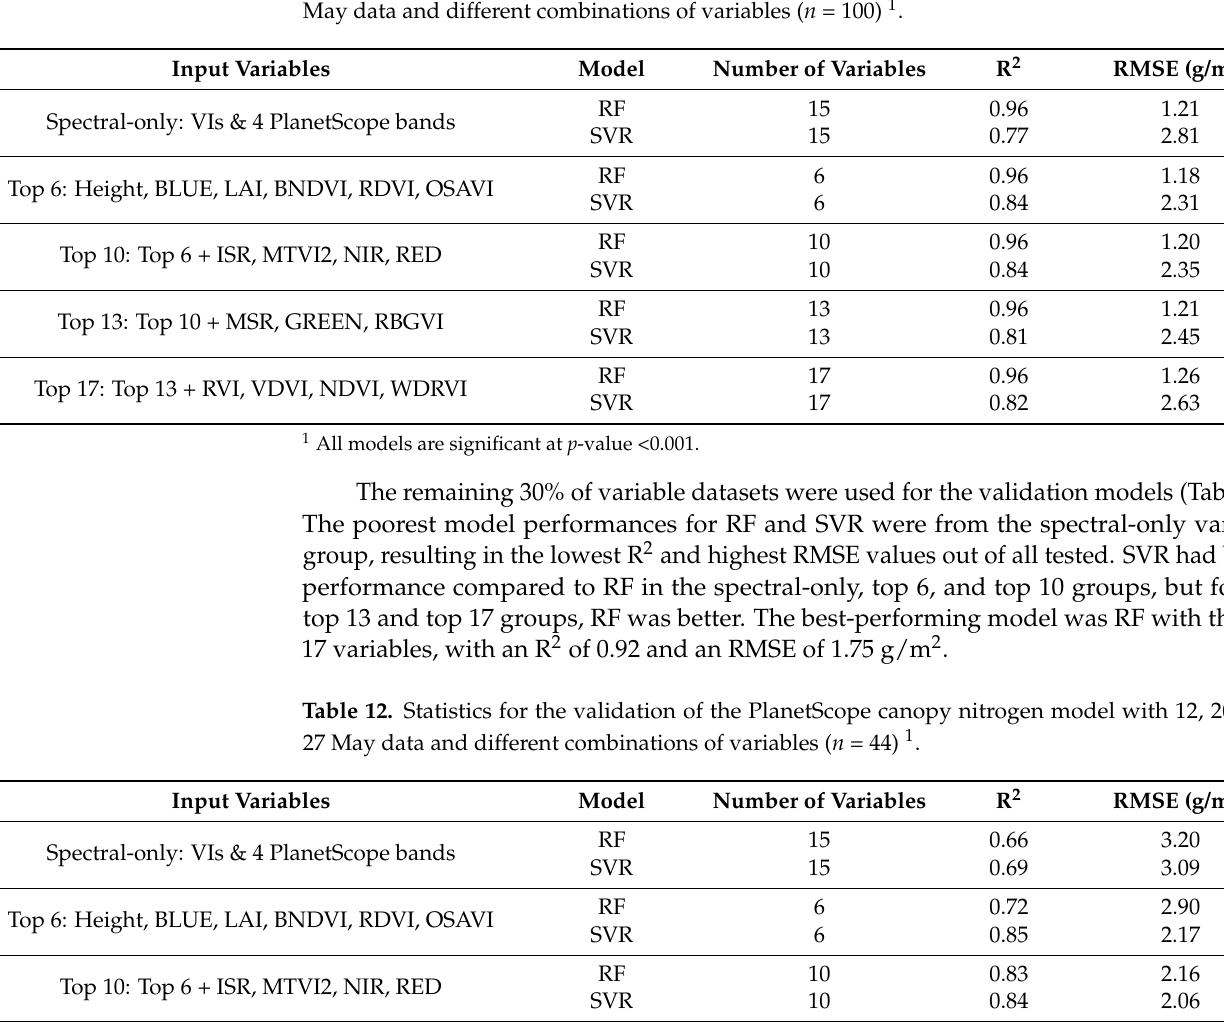
Table 11. Statistics for the calibration of the PlanetScope canopy nitrogen model with 12, 20, and 27 May data and different combinations of variables ( n = 100) 1 .